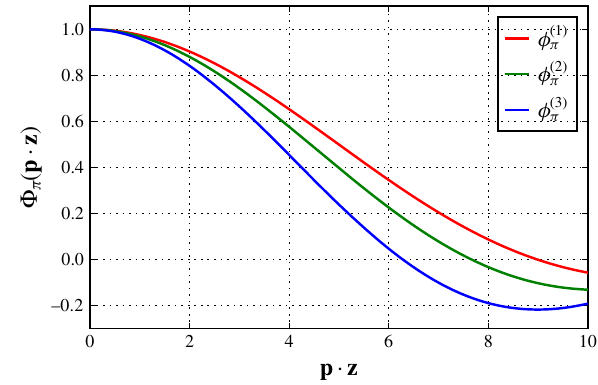
Fig. 2 The position space pion DA Φ π ( p · z ) [cf. Eq. (5)] for the three models in Eq.